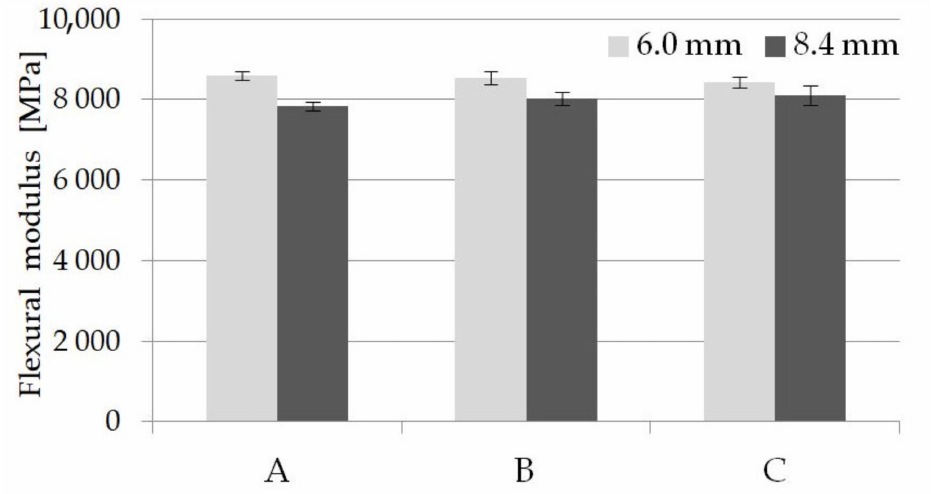
Figure 13. Influence of nitrogen pressure on the flexural modulus for unfoamed and foamed thick- walled PA66 GF30 molded parts, where A is a solid sample, while B and C are foamed at 16 and 20 MPa nitrogen pressure respectively.